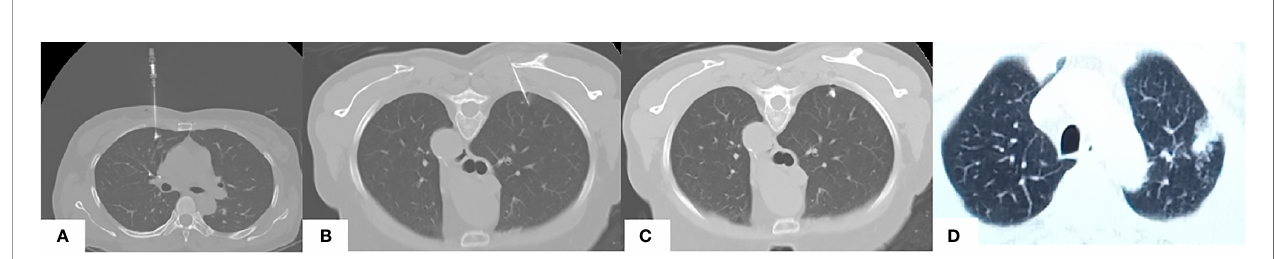
FIGURE 1 | CT guided images of pulmonary nodule localization. (A) CT-guided injection of the iodized indocyanine green at the region of the pulmonary ground- glass opacity of a 51-year-old female. Note the supine position due to the ventral side of the nodule. (B, C) CT-guided hook wire localization of the pulmonary ground-glass opacity in the right upper lobe region covered by the scapula in a 62-year-old female, note the prone position due to the dorsal side of this nodule and the needle pathway is tilted to detour the scapula. (D) Final CT con fi rmed parenchymal hemorrhage in the upper lobe of the left lung in a 53-year-old male, note the emerging area of consolidation developed in the track of the puncture in the left